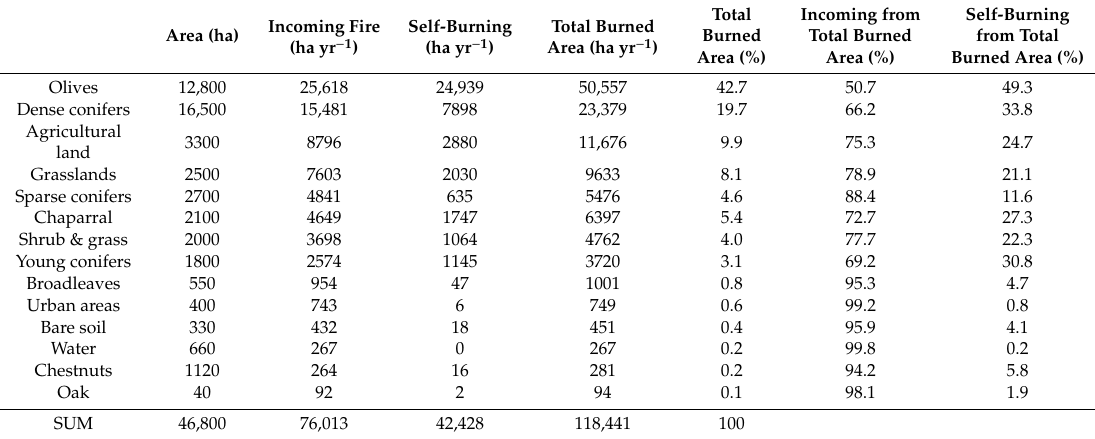
Figure 4. ( A ) Relative amounts of incoming, outgoing, and self-burning wildfire for the major land cover types in Lesvos Island, Greece by total simulated annual area burned; ( B ) percent within each land tenure; ( C ) wildfire transmission network among the land cover types. Network edges in ( C ) represent wildfire transmitted from one land tenure to another, as shown by the arrow and colored by its source. The size of each node corresponds to the amount of fire transmitted and received from that node. Table 3. Burned area by land cover type and fire type (incoming or self-burning). Total burned area is the sum of incoming and self-burning